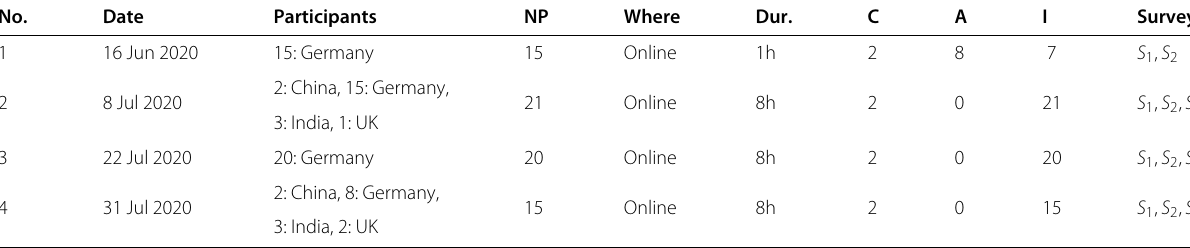
Table 4 Overview of CSC Events with Sifu